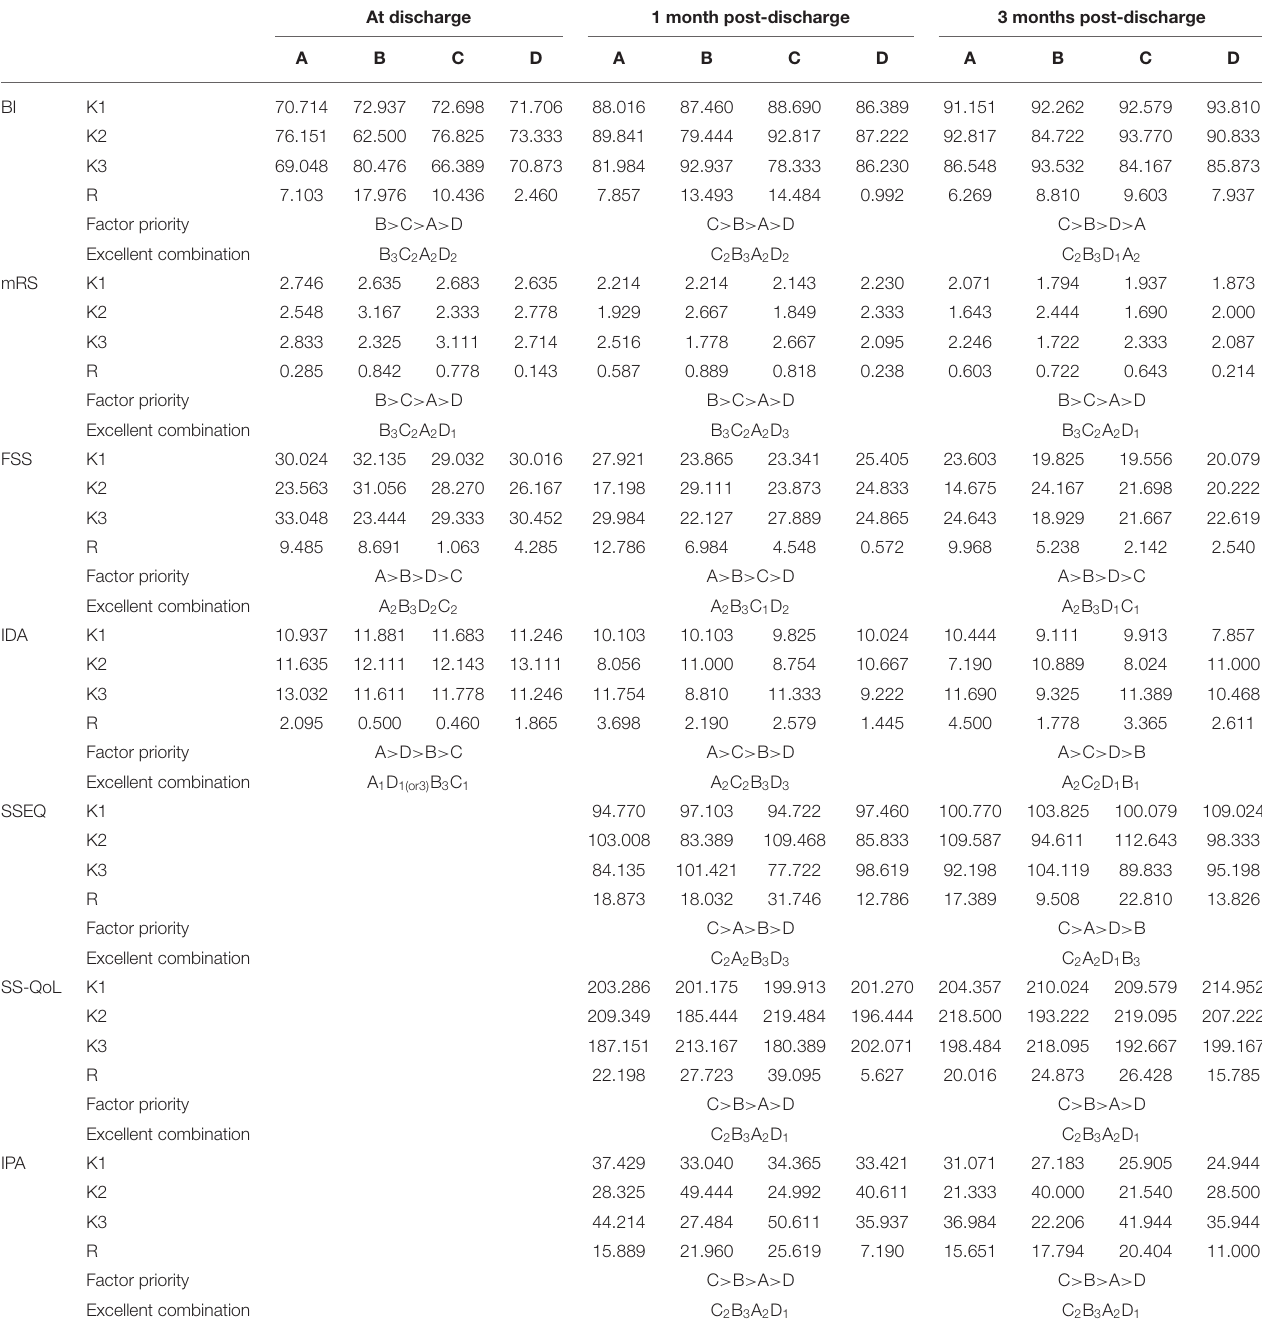
TABLE 5 | Results of the range analysis of the effect of early mobilization.